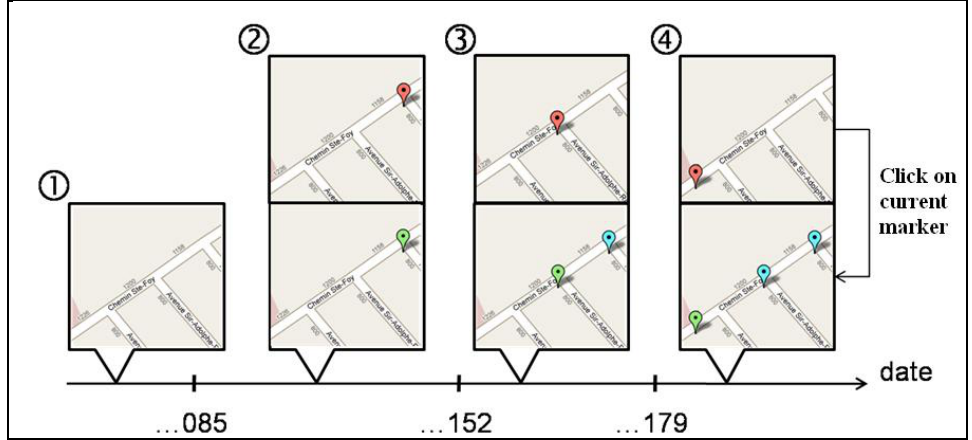
Figure 5. Viewing the current state of an object according to the date set by the